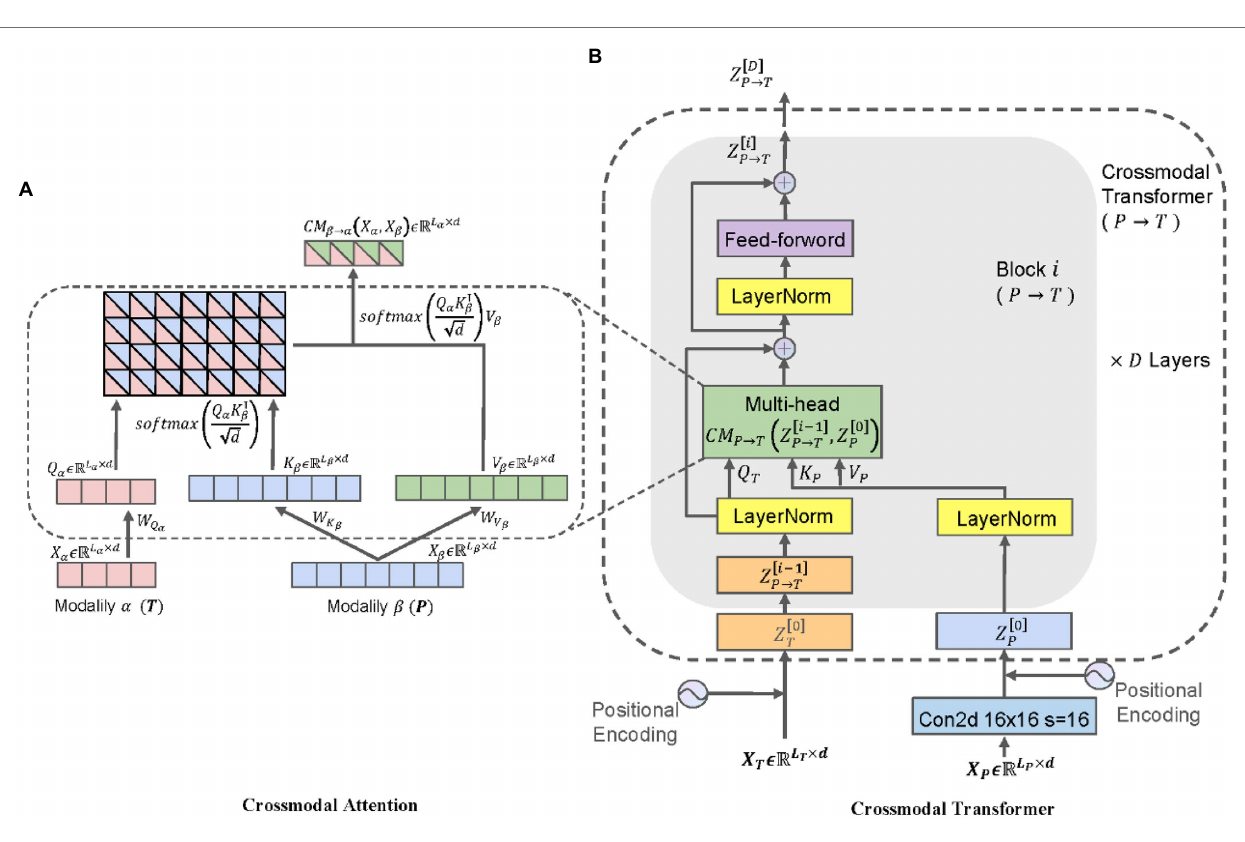
FIGURE 2 | The working principle of fine-grained disease-spot region detection.